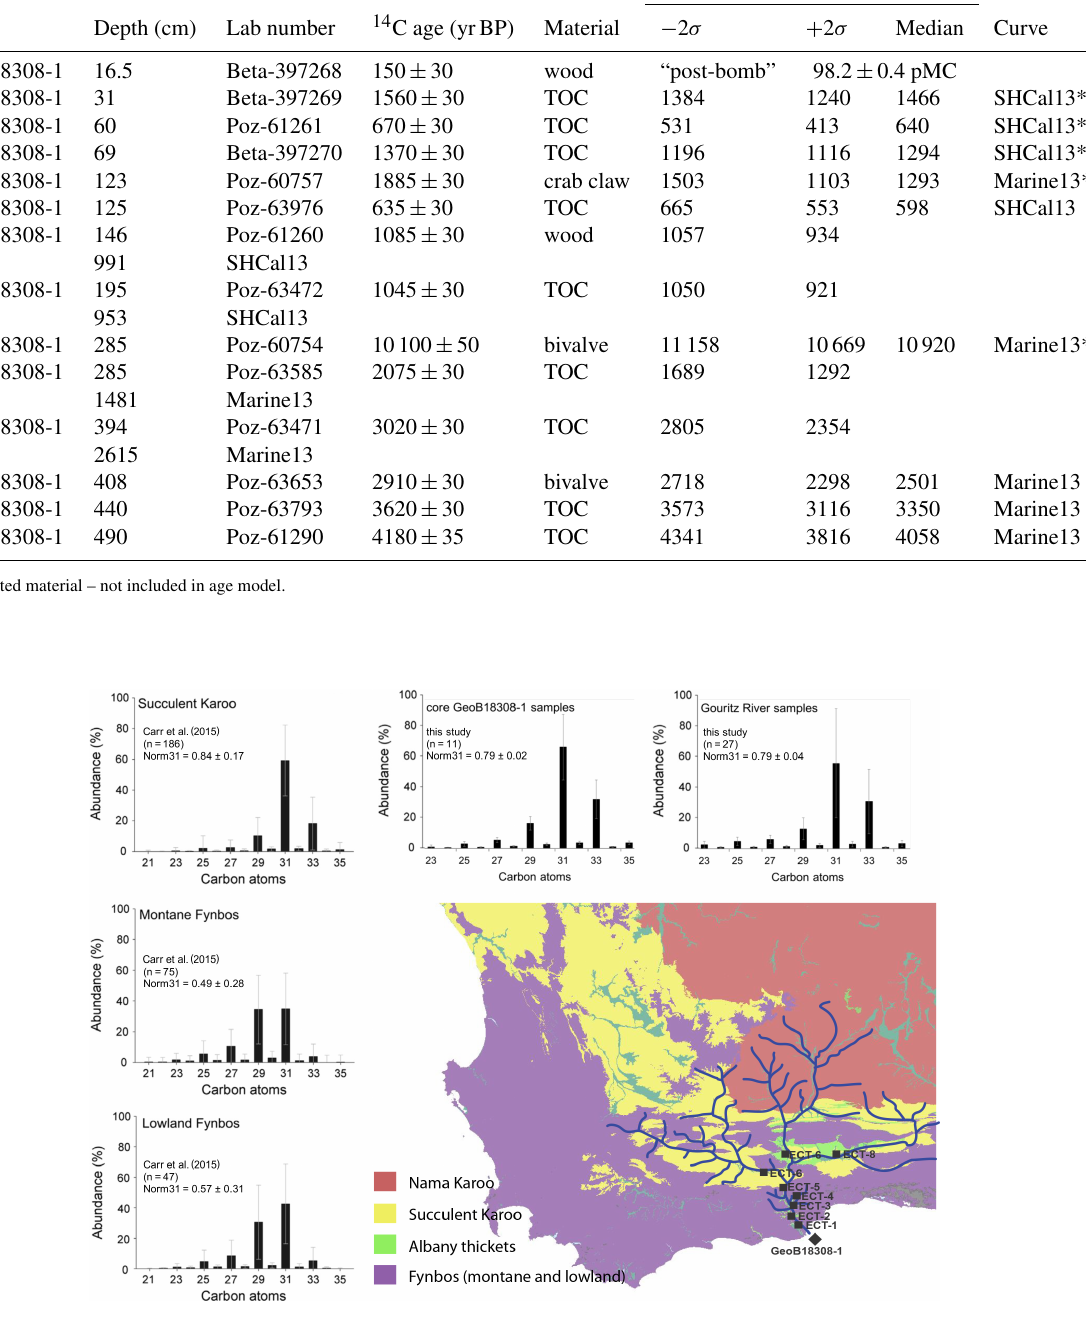
Figure 2. The map is an enlargement of Fig. 1 and shows vegetation types in and around the drainage basin (after Mucina and Rutherford, 2006 and Scott et al., 2012) of the Gouritz River. Squares indicate localities of Gouritz River samples; diamond indicates marine sediment core location. Plots showing regional biome/ecoregion soil and vegetation average n -alkane distributions from Carr et al. (2015) are indicated on the left, whereas average n -alkane distributions of riverine and marine samples from this study are plotted above the